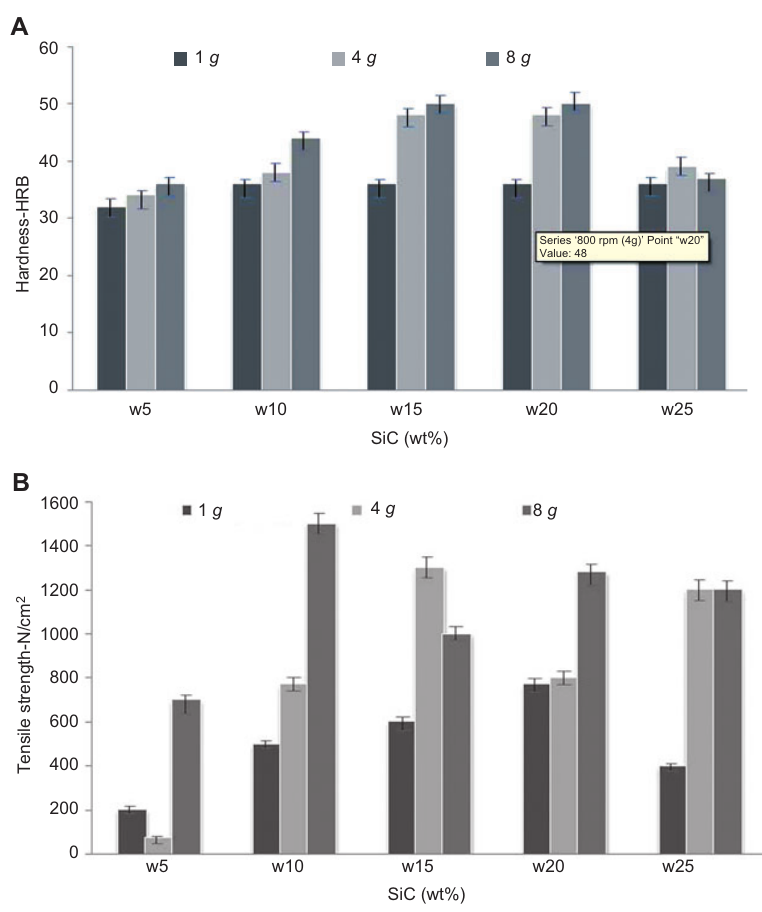
Figure 1 Al-Si composite. (A) Hardness and SiC content at the stirring velocity of 1, 4 and 8 g . The maximum hardness is obtained by using 15 wt. % of SiC and stirring velocities of 8 g and increases to approximately 48 HRB. (B) Tensile strength and SiC content at the stir- ring velocity of 1, 4 and 8 g . At 1, 4 and 8 g , the maximum strengths are obtained by 20, 15 and 10 wt. % of SiC, 700, 1250 and 1450 N/cm 2 , respectively. distributed in the aluminum matrix. There are some SiC clusters in the matrix resulting from low stirring velocity and decreas- ing the tensile strength. Figure 2B depicts the microstructure of specimen with 20 wt. % of SiC and stirring velocity of 4 g .